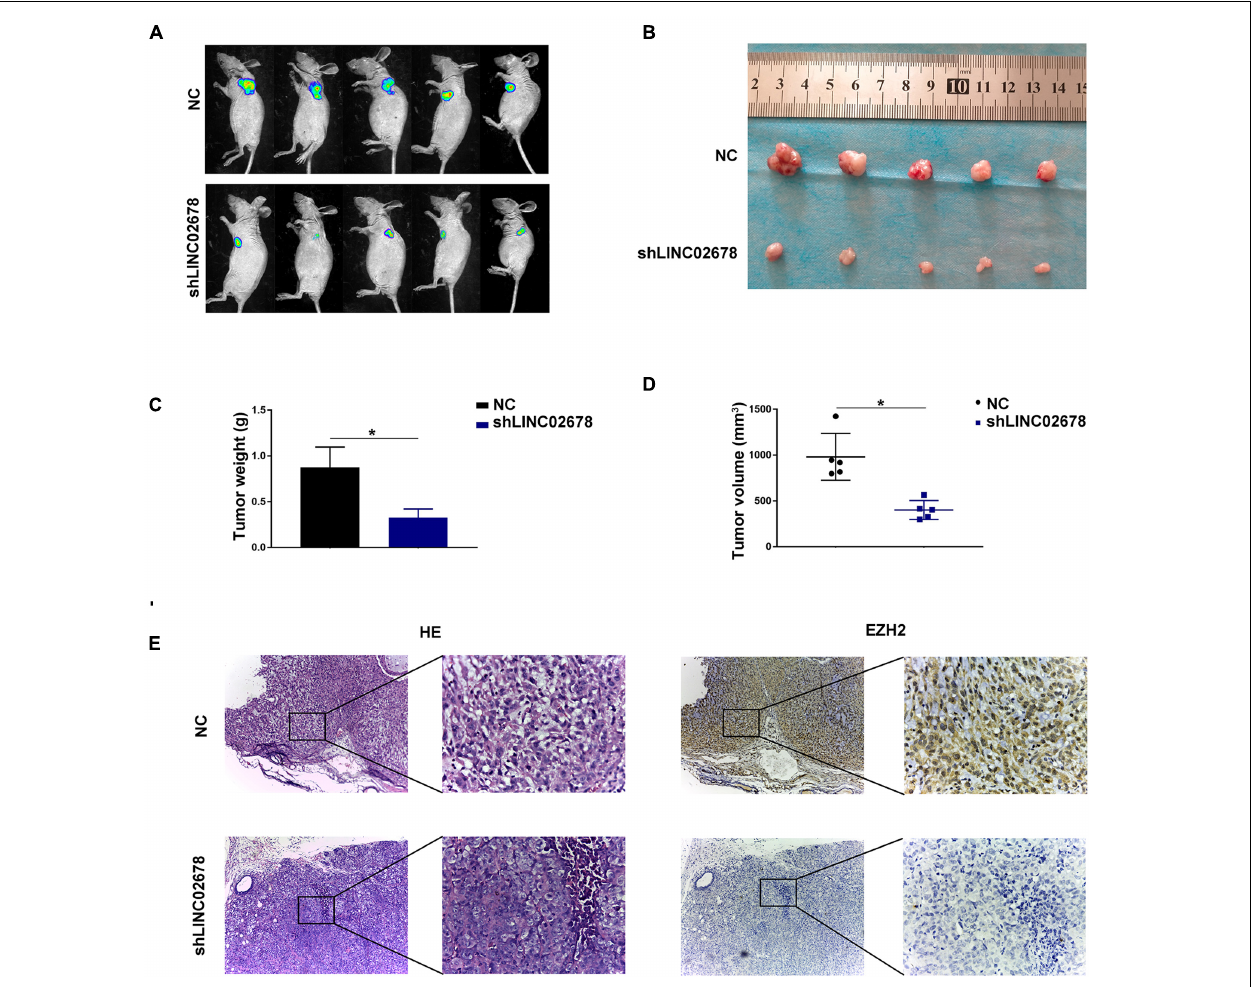
FIGURE 7 | Depletion of LINC02678 repressed tumor growth in vivo . (A) Representative bioluminescence images of nude mice bearing luciferase-labeled tumors via subcutaneous injection of NC and shLINC02678 groups. (B) Representative images of detached tumors from the NC and shLINC02678 groups. (C) Histogram of the final tumor weights from NC and shLINC02678 groups. (D) Tumor volumes from NC and shLINC02678 groups. (E) Representative images of the HE and immunohistochemical staining of EZH2 expression in nude mice xenograft tumor sections (magnification, × 100 and × 400). (* p < 0.05. Data were obtained from three independent